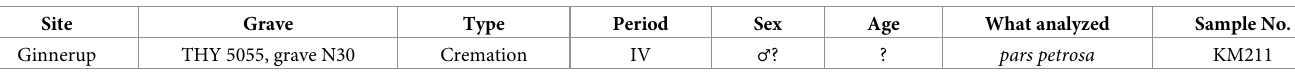
Table 4. Details of material sampled from Late Nordic Bronze Age Thisted